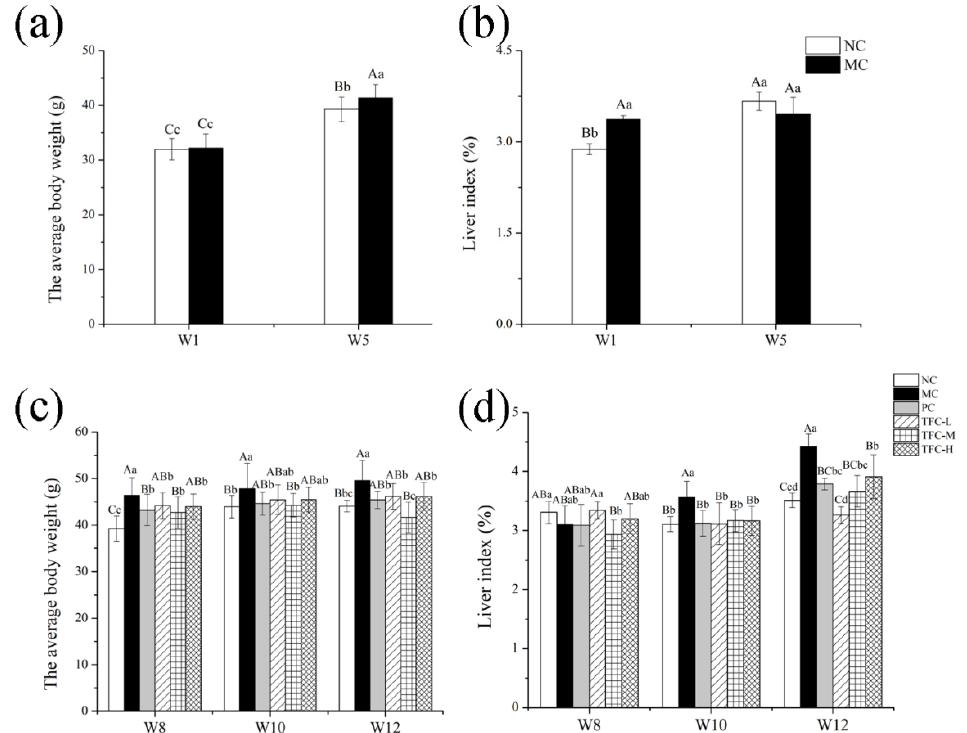
Figure 3. Effects of TFC on weight gain and liver index: ( a ) body weight in the first week and the fifth week; ( b ) liver index in the first week and the fifth week; ( c ) body weight in the eighth week, the tenth week, and the twelfth week; and ( d ) liver index in the eighth week, the tenth week, and the